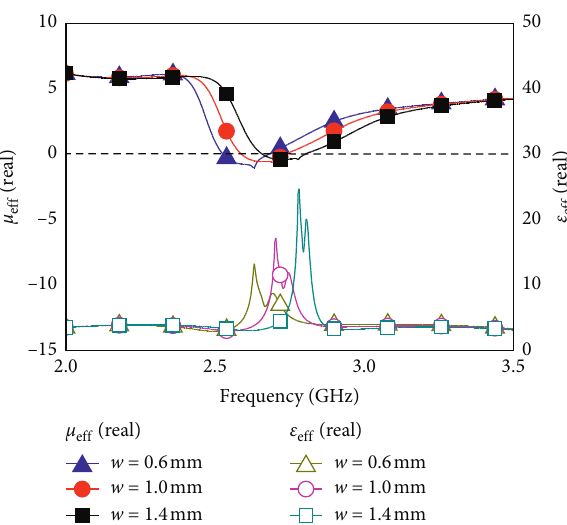
Figure 8: Effective response of SRR with different w